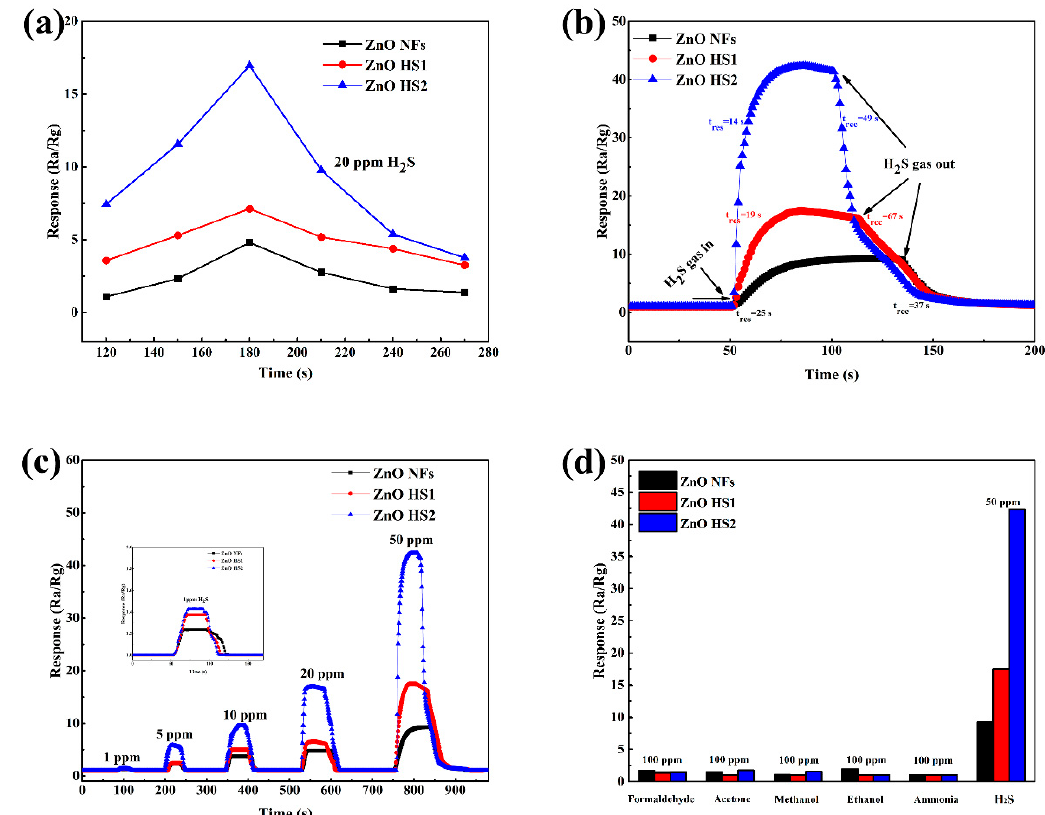
Figure 7. ( a ) Responses of heat-treated ZnO NFs, ZnO HS1 and ZnO HS2 gas sensors toward 20 ppm H 2 S gas at different operating temperatures, ranging from 120 °C to 270 °C. ( b ) Dynamic transient sensing of heat-treated ZnO NFs, ZnO HS1 and ZnO HS2 gas sensors toward 50 ppm H 2 S gas at 180 °C. ( c ) Response-recovery curves of the ZnO NFs, ZnO HS1 and ZnO HS2 gas sensors under different concentrations of H 2 S gas, ranging from 1 to 100 ppm at 180 °C. ( d ) The responses of heat-treated gas sensors based on ZnO NFs, ZnO HS1 and ZnO HS2 toward 50 ppm H 2 S gas and different 100 ppm gases at 180 °C.